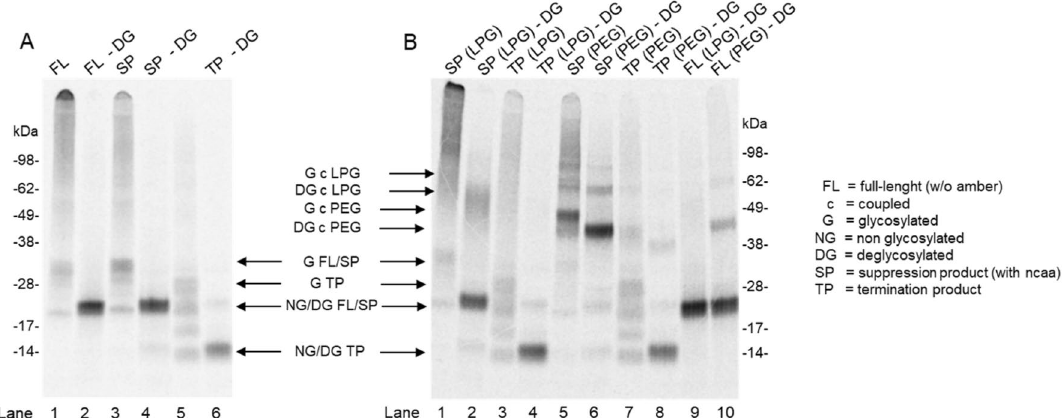
Figure 2. Chemoselective coupling of erythropoietin with LPG-BCN and PEG-BCN. ( A ) Autoradiography of different EPO variants: lane 1 and 2 full-length EPO without non-canonical amino acid, lane 3 and 4 suppression product with incorporated p-azido-L-phenylalanine, lane 5 and 6 termination product terminated at the amber stop codon. Each variant was analyzed in absence (lane 1, 3, 5) and presence (lane 2, 4, 6) of glycosidase PNGase F. Successful incorporation of AzF led to a comparable band pattern as seen for the full-length EPO without non-canonical amino acid. Synthesis of EPO (with amber stop codon) in absence of eAzFRS led to band pattern at a reduced molecular weight as expected for the truncated product. ( B ) Autoradiography after coupling of LPG-BCN and PEG-BCN to EPO. Lane 1–4 and lane 9 show the coupling of LPG-BCN to AzF containing EPO (lane 1–2), terminated EPO (lane 3–4) and full-length EPO (lane 9) in absence (lane 1 and 3) and presence (lane 2, 4, 9) of PNGase F. The successful coupling of LPG-BCN to AzF containing EPO is seen by a shift of EPO corresponding bands to a higher molecular weight (lane 1 and 2) at around 50–60 kDa. Lane 5–8 and lane 10 show the coupling of PEG-BCN to AzF containing EPO (lane 5–6), terminated EPO (lane 7–8) and full-length EPO (lane 10) in absence (lane 5 and 7) and presence (lane 6, 8, 10) of PNGase F. The successful coupling of PEG-BCN to AzF containing EPO is seen by a shift of EPO corresponding bands to a higher molecular weight (lane 5 and 6) at around 40–48 kDa. Uncropped autoradiography images are included in Supplementary